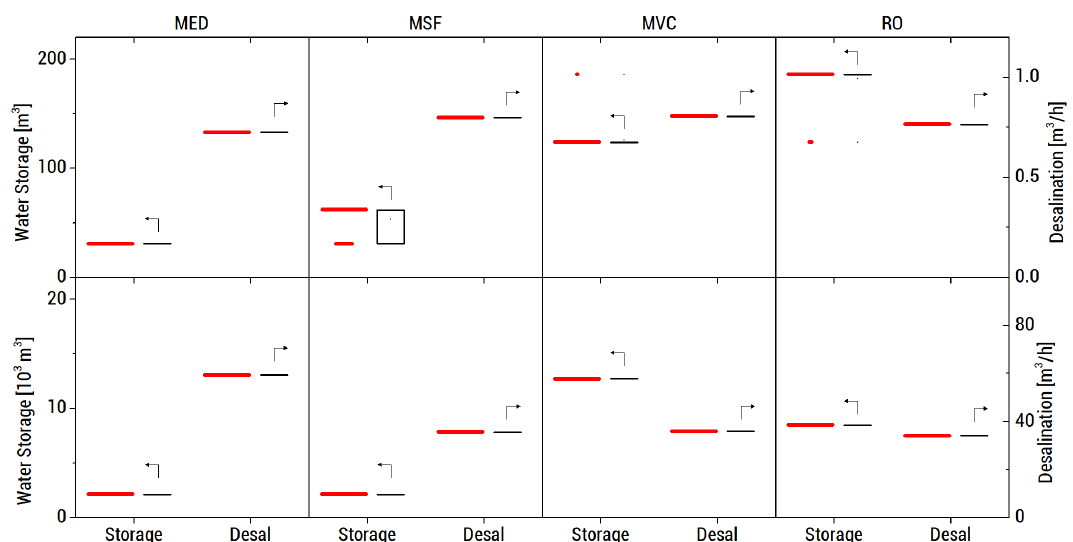
Figure 18. Distribution of optimum sizes of energy components on Camasusu Island (top) and Lubang Island (bottom) at +25% overnight fuel price.